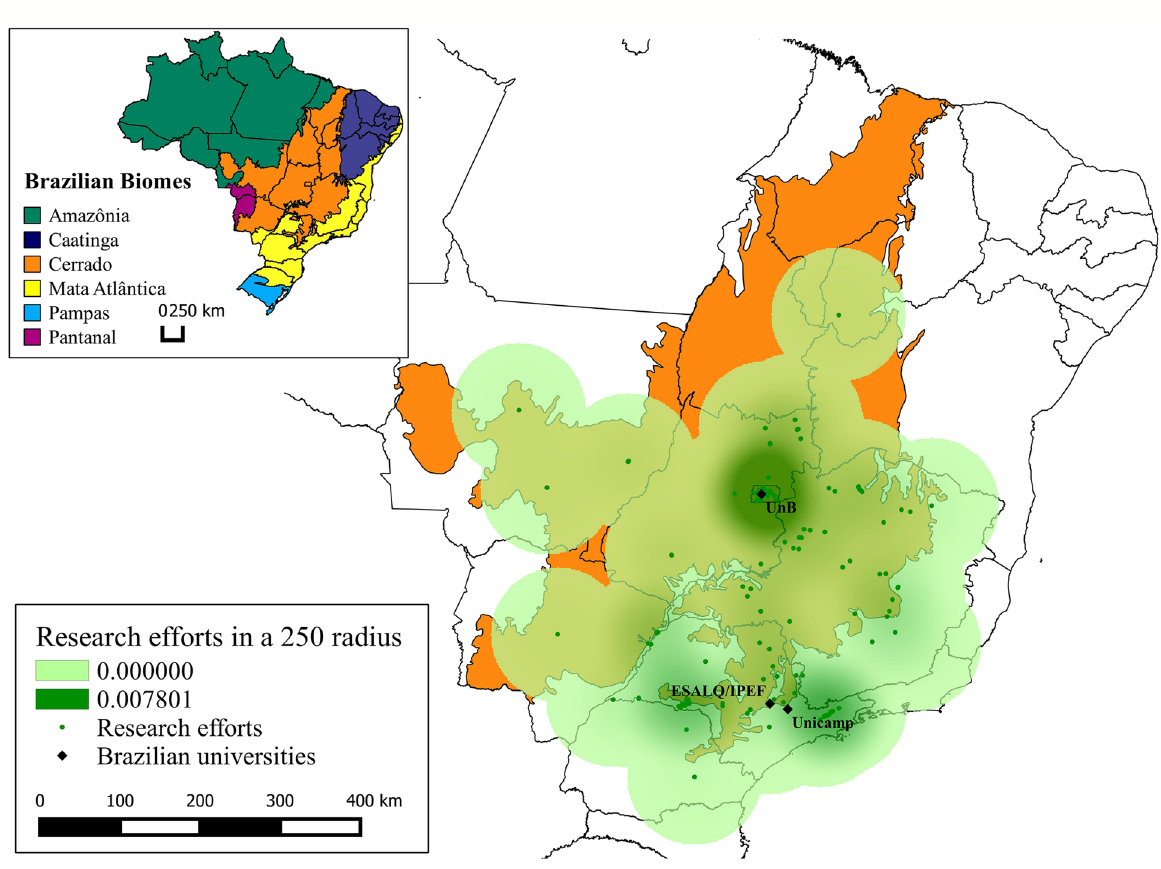
Figure 1. The concentration of research efforts of Cerrado restoration is represented in a kernel map. The intensity of green circles positively increases with the number of research efforts. The exact location of the research are also pointed in the map. Some research groups of public universities are pointed: Universidade de Brasília (UnB), Universidade Estadual de Campinas (Unicamp) and Escola Superior de Agricultura Luiz de Queiroz (ESALQ- USP). *Some publications were not shown in the map: two publications that focused in the whole Cerrado; six publications that generally focused on restoration of native ecosystems of Brazil; and three publications conducted in Goiás and Tocantins states that did not provide specific geographic